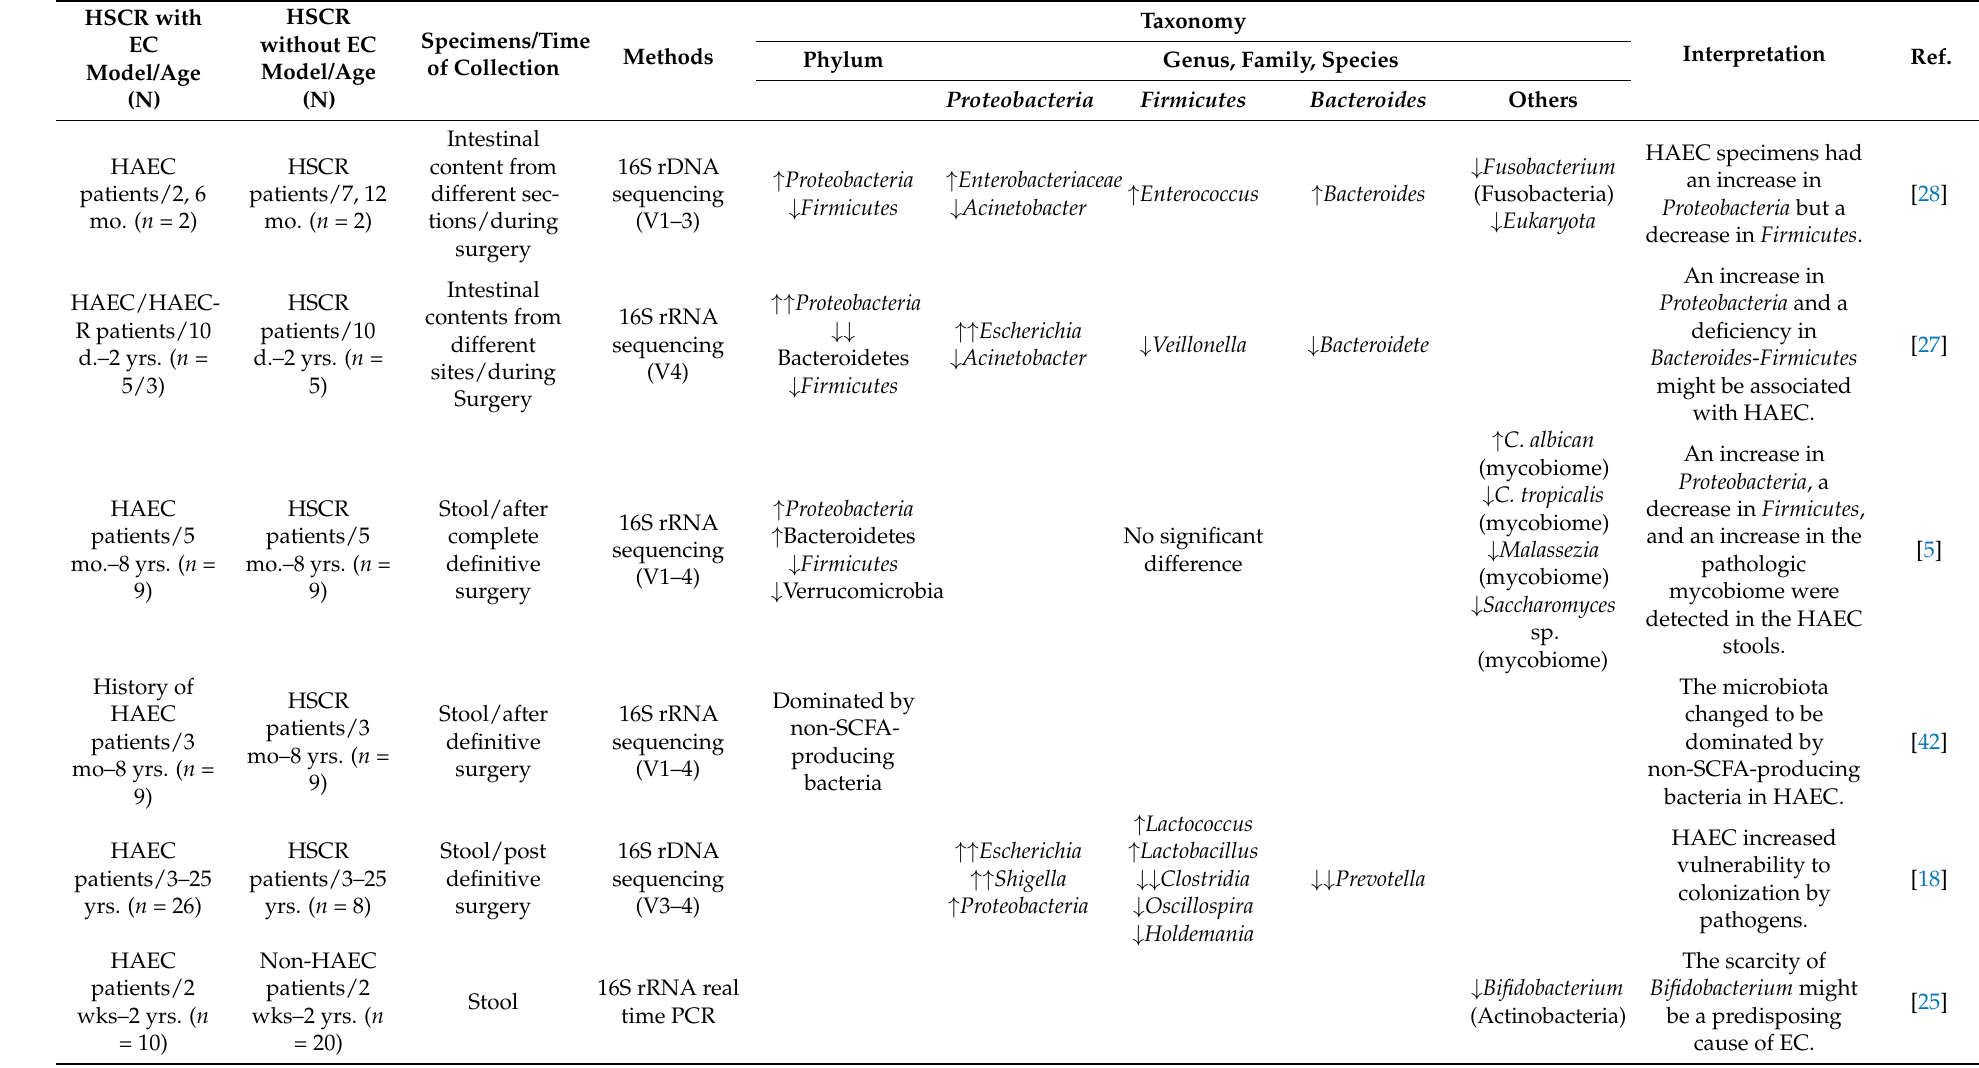
Table 4. The alterations of gut microbiota taxa in Hirschsprung’s disease with and without enterocolitis: evidence from animal to clinical